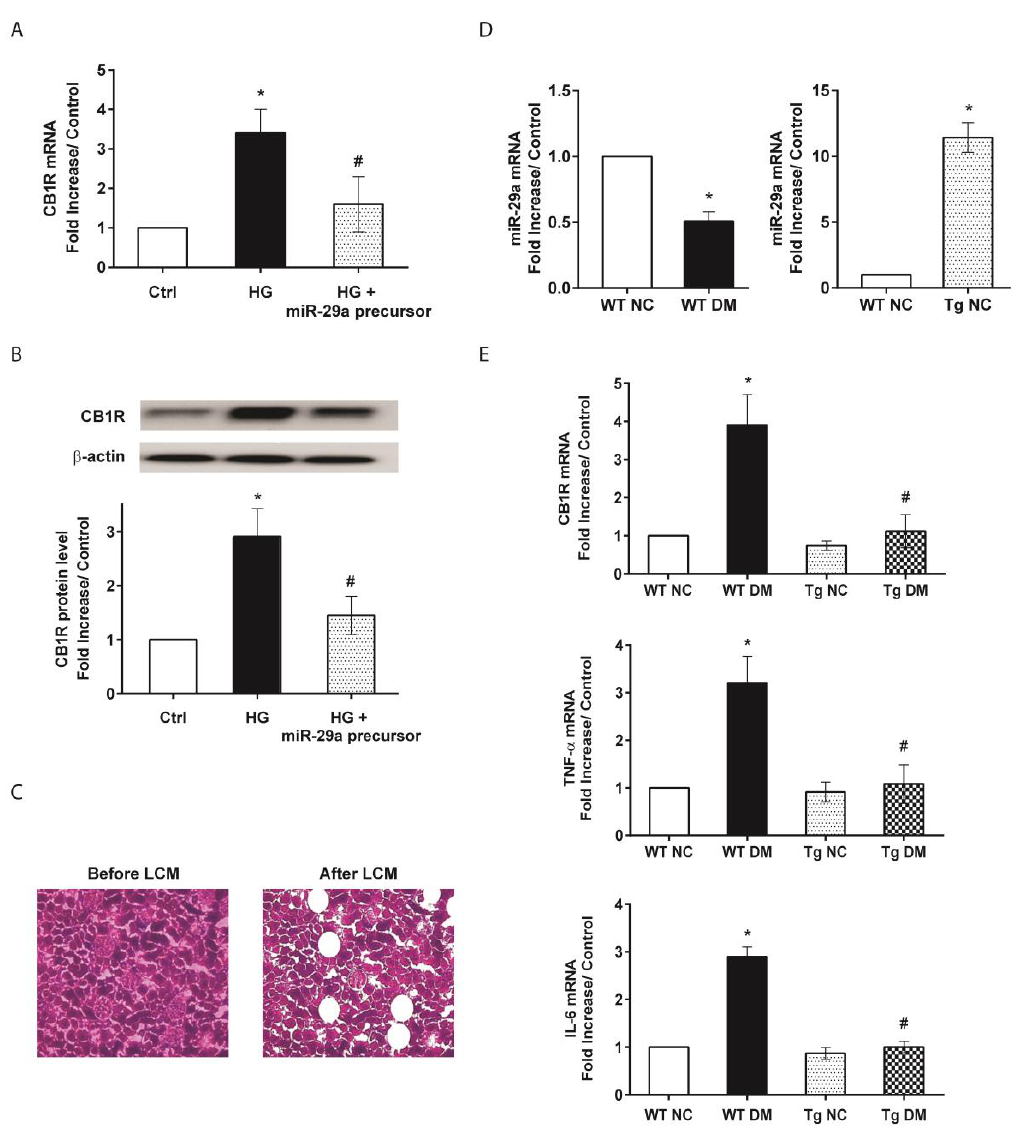
Figure 1. Influences of microRNA-29a (miR-29a) on the expressions of cannabinoid receptor type 1 (CB1R) and profibrotic genes in vitro and in glomeruli of diabetic mice. ( A ) Effects of high glucose (HG) and miR-29a precursor on CB1R expression in cultured renal mesangial cells by quantitative RT-PCR analysis. ( B ) Western blot analysis of CB1R protein in mesangial cells. Relative expression levels of CB1R protein quantified by densitometry are shown in the bottom panel. All experimental results from quantitative RT-PCR or Western blotting are presented as means ± standard error of the mean (SEM) calculated from three independent experiments. The symbol * indicates significant difference vs. the control group ( p < 0.05); the symbol # indicates significant difference vs. the HG group ( p < 0.05). ( C ) Isolation of glomerular components in renal tissues by laser capture microdissection (LCM). ( D ) mRNA expression of miR-29a in diabetic (left panel) and transgenic mice (right panel). ( E ) The mRNA expression levels of CB1R, tumor necrosis factor- α (TNF- α ), and interleukin-6 (IL-6), normalized to that of β -actin, in glomeruli of wild-type normal control (WT NC), wild-type diabetic (WT DM), miR-29a transgenic normal control (Tg NC), and miR-29a transgenic diabetic mice were quantified by qRT-PCR (n = 6). The symbol * indicates significant difference vs. the WT NC group ( p < 0.05); the symbol # indicates significant difference vs. the WT DM group ( p < 0.05).